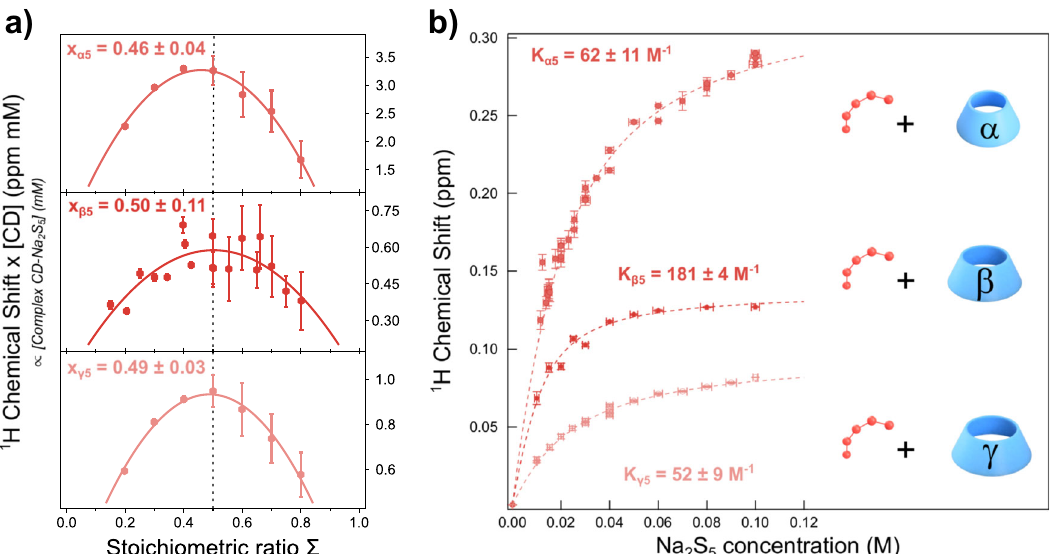
Fig. 2 In fl uence of the nature of cyclodextrin on the Na 2 S 5 /cyclodextrin host-guest interaction. a Experimental Job ’ s plot obtained following H 3 shift for α -cyclodextrins, β -cyclodextrins, and γ -cyclodextrins in presence of Na fi tting whose maximum is 2 S 5 (respectively, top-down). Second order polynomial obtained for the stoichiometric ratio, ∑ , (see “ Methods ” section) matches with the stoichiometry of the complex. b 1 H NMR titration plots for the inclusion of Na 2 S 5 in the different cyclodextrins cavities and fi tted binding isotherms determined from H 3 signal for α -cyclodextrins, β -cyclodextrins, γ -cyclodextrin with indication of the resulting association constants K α 5 , K β 5 , and K γ 5 for the corresponding 1:1 inclusion complex. The statistic error relative to the chemical shift measurement was obtained by the calculation of the standard deviation of 10 similar and independent points and is estimated to 9%. The plotted error bars were calculated considering the uncertainties propagation (see “ Methods ” section).